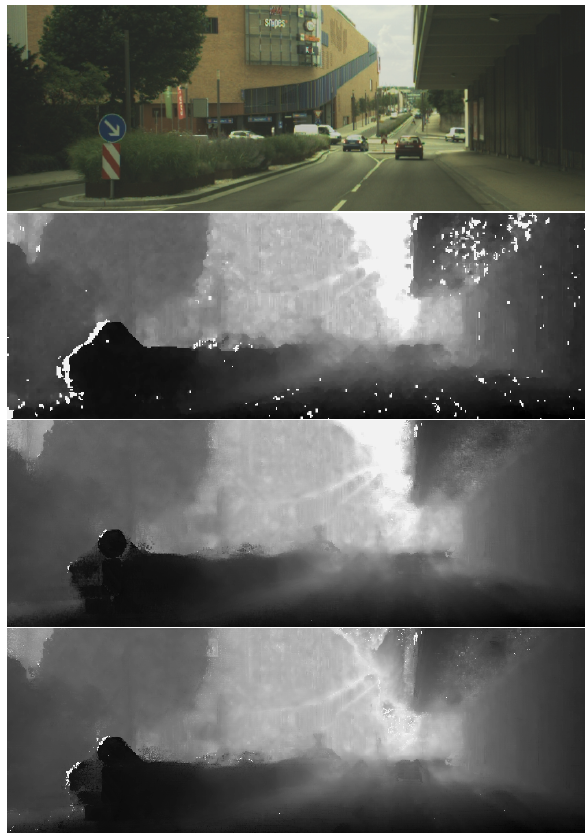
Figure 3. Picture detail of traffic scene. From top to bottom: Left color image, SGM image, output of basic variant (10 IVs, thresh- old=0.1), output of feedback variant (5 IVs, threshold=0.07). Note the contours of the sign on the left hand side